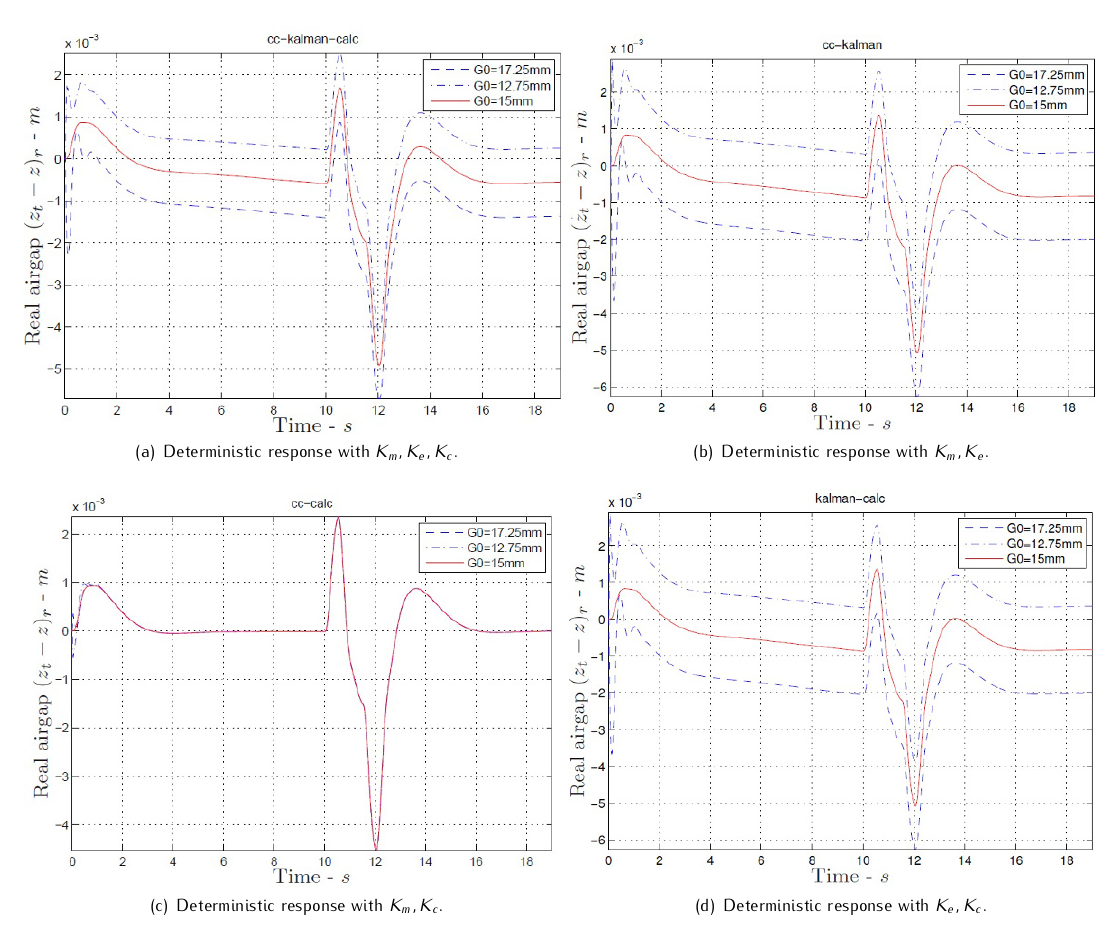
Figure 15. Deterministic response of the suspension with the various control configurations.